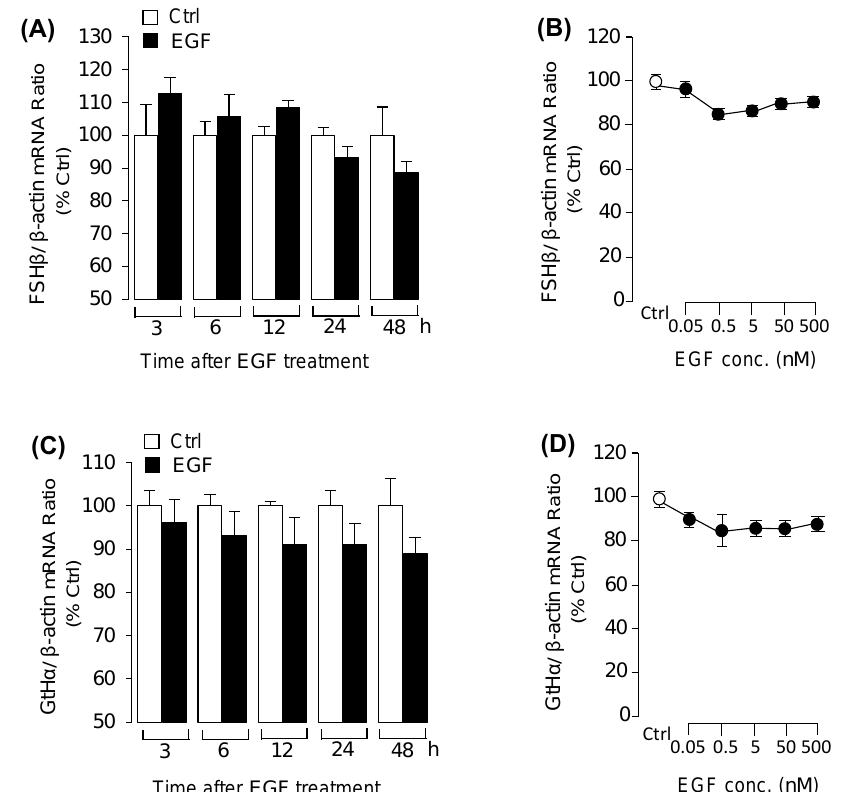
Figure 2. The effects of EGF on follicle-stimulating hormone beta (FSHβ) and gonadotropin subunit alpha (GtHα) mRNA expression in pituitary cells. ( A ) Time experiment of EGF (50 nM) on FSHβ mRNA expression from 3 to 48 h. ( B ) Dose experiment with increasing dose of EGF (0.05–500 nM) on FSHβ mRNA expression for 48-h incubation. ( C ) Time course of EGF (50 nM) on GtHα mRNA expression. ( D ) With increasing concentration of EGF (0.05–500nM) on GtHα mRNA expression for 48-h incubation. After drug treatment, the total RNA was collected and prepared for FSHβ and GtHα mRNA expression by using real-time PCR. Data presented are expressed as mean ± SEM ( n = 4). And the different letters represent a significant difference at p < 0.05 between groups.